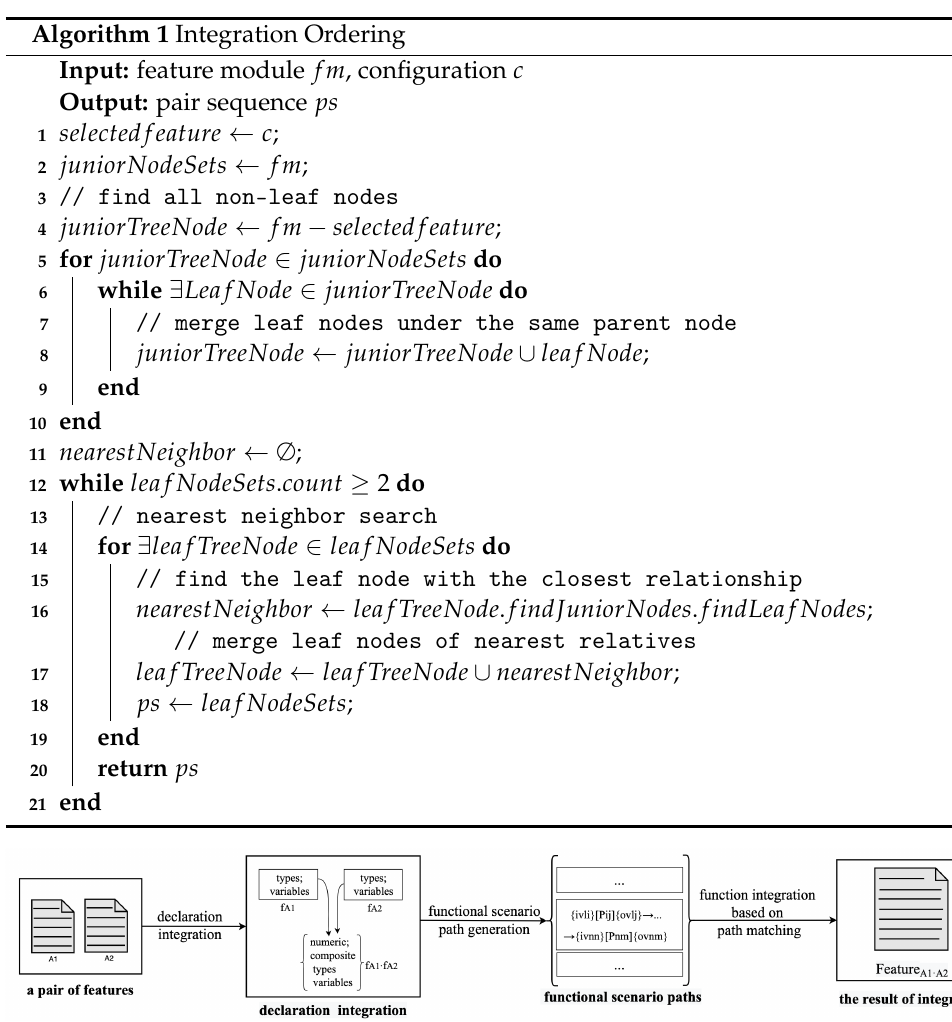
Figure 5. Integration of feature